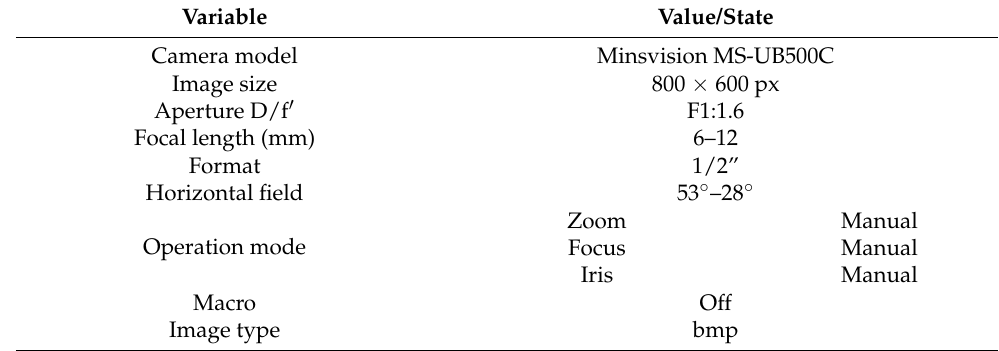
Table 1. Camera parameter setting.